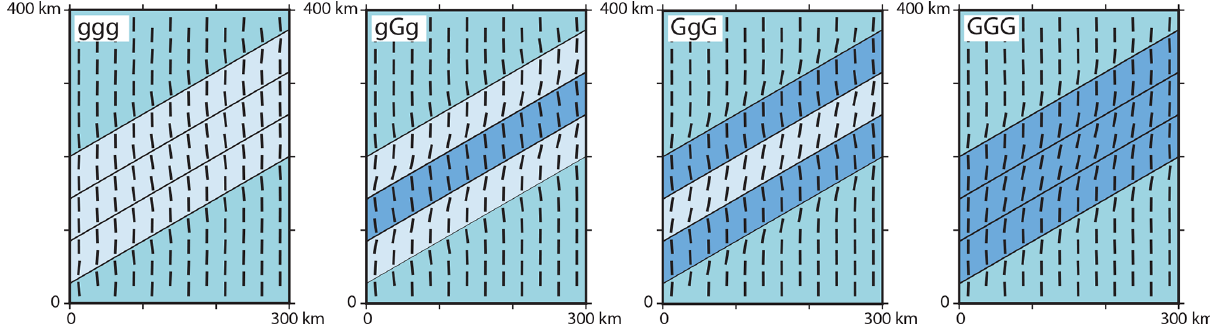
Figure 6. Influence of density on the stress orientation. Black bars represent the orientation of S Hmax at a depth of 1000m. Colours indicate the material properties used. The medium blue area uses the reference material properties ( ρ = 2 . 7gcm − 3 ), the light blue material uses